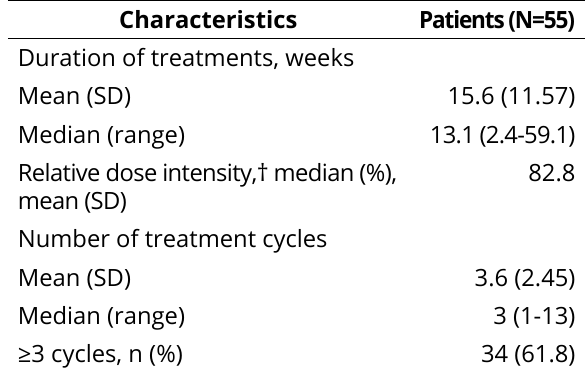
Table 2. Treatment exposure.